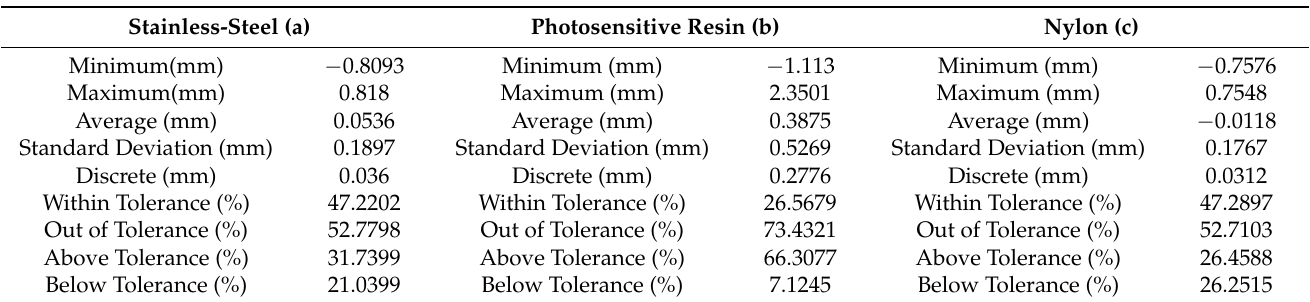
Figure 6. ( a ) Stainless steel forming inaccuracies frequency distribution diagram (frequency percentage); ( b ) photosensitive resin forming inaccuracies frequency distribution diagram (frequency percentage); ( c ) nylon forming inaccuracies frequency distribution diagram (frequency percentage). Table 1. (a) Stainless steel forming inaccuracies statistics; (b) photosensitive resin molding inaccura- cies statistics; (c) nylon molding inaccuracies